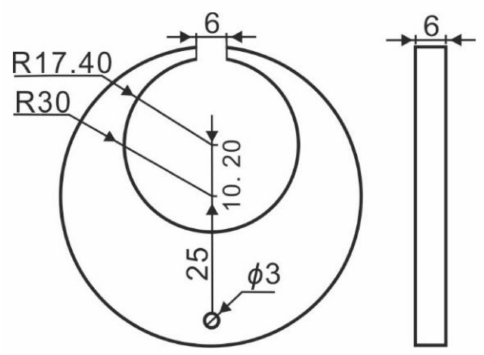
Figure 2. C-ring geometry (all dimensions in